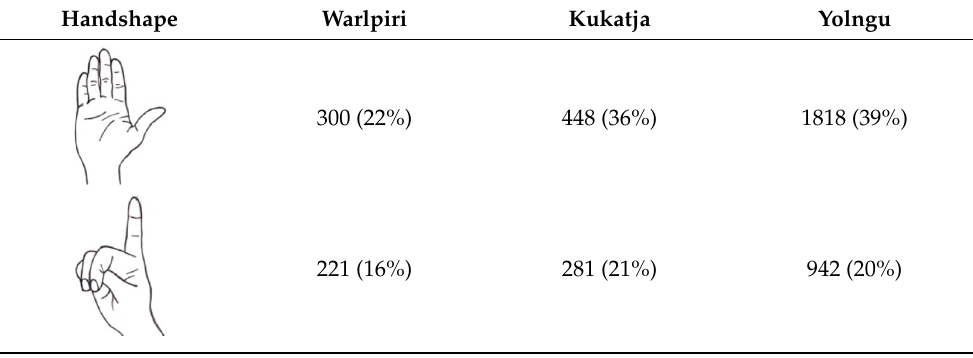
Table 2. Frequencies and token counts for eleven handshapes shared between Warlpiri, Kukatja and Yolngu sign.